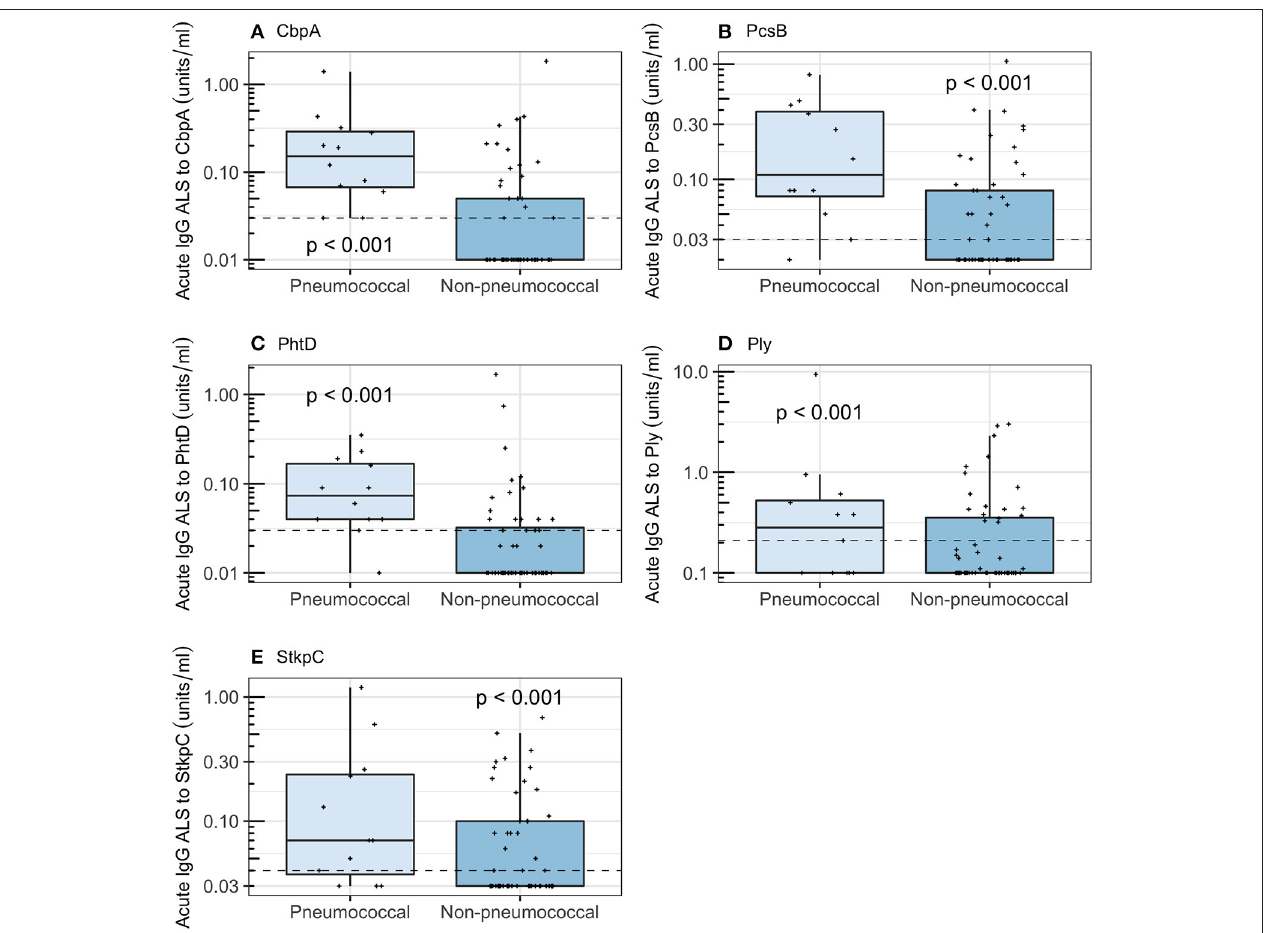
FIGURE 4 | Acute IgG ALS to pneumococcal proteins by children with pneumococcal pneumonia and non-pneumococcal pneumonia in all children enrolled into the study. Dashed horizontal lines represent thresholds derived from the Youden Index, p -values were derived from the Wilcoxon rank sum test. (A) Choline binding protein A (CbpA); (B) protein for cell wall separation of group B streptococci (PcsB); (C) pneumococcal histidine triad D (PhtD); (D) pneumolysin (Ply); (E) serine threonine kinase protein C (StkpC). TABLE 2 | Diagnostic accuracy, using thresholds derived from the Youden Index, for acute IgG ALS to pneumococcal proteins to discriminate between pneumococcal pneumonia and non-pneumococcal pneumonia in children with pneumonia in Nepal (all age